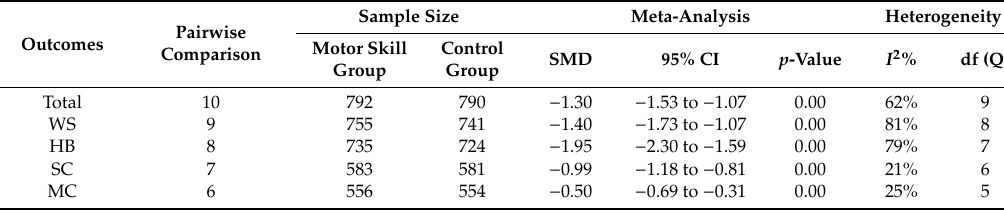
Table 3. Synthesized results for the effects of exercises versus control condition.